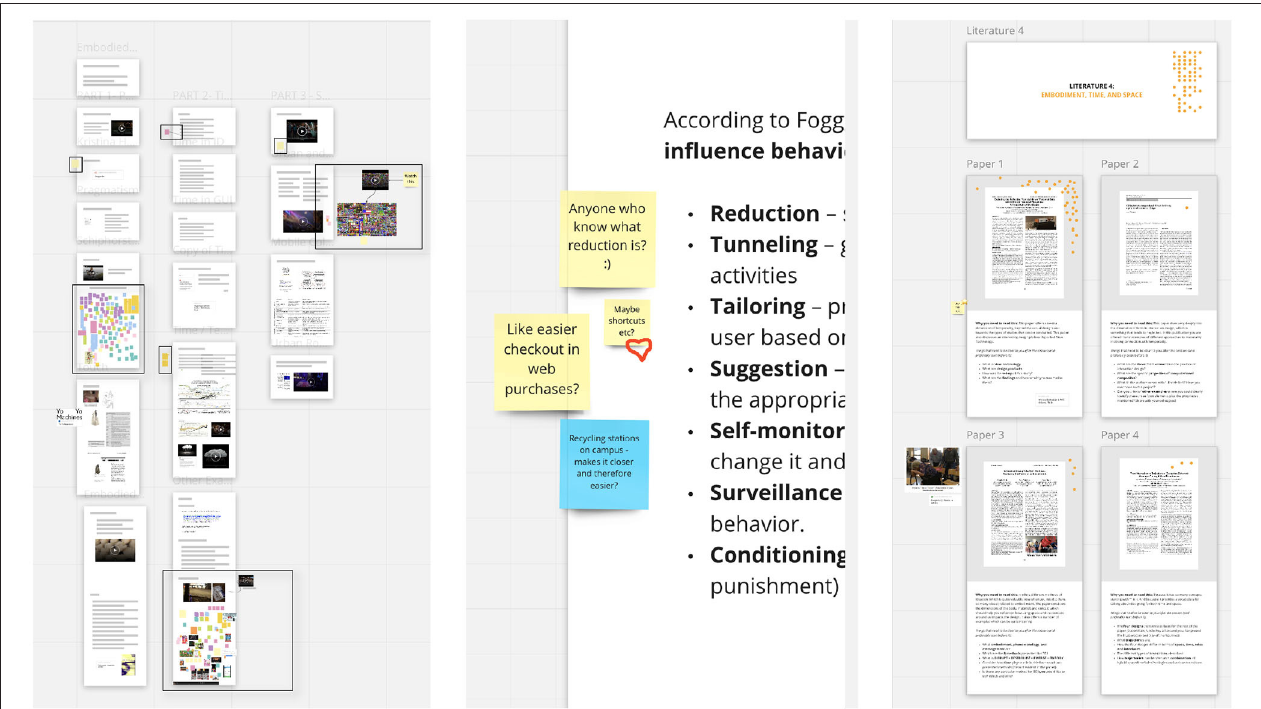
FIGURE 3 | Three screenshots from Miro boards. To the left, lecture slides with student input marked in black squares. In the middle, students helping one another figuring out some of the literature. To the right, a board showing the weekly literature with dot-voting, but also added information by the